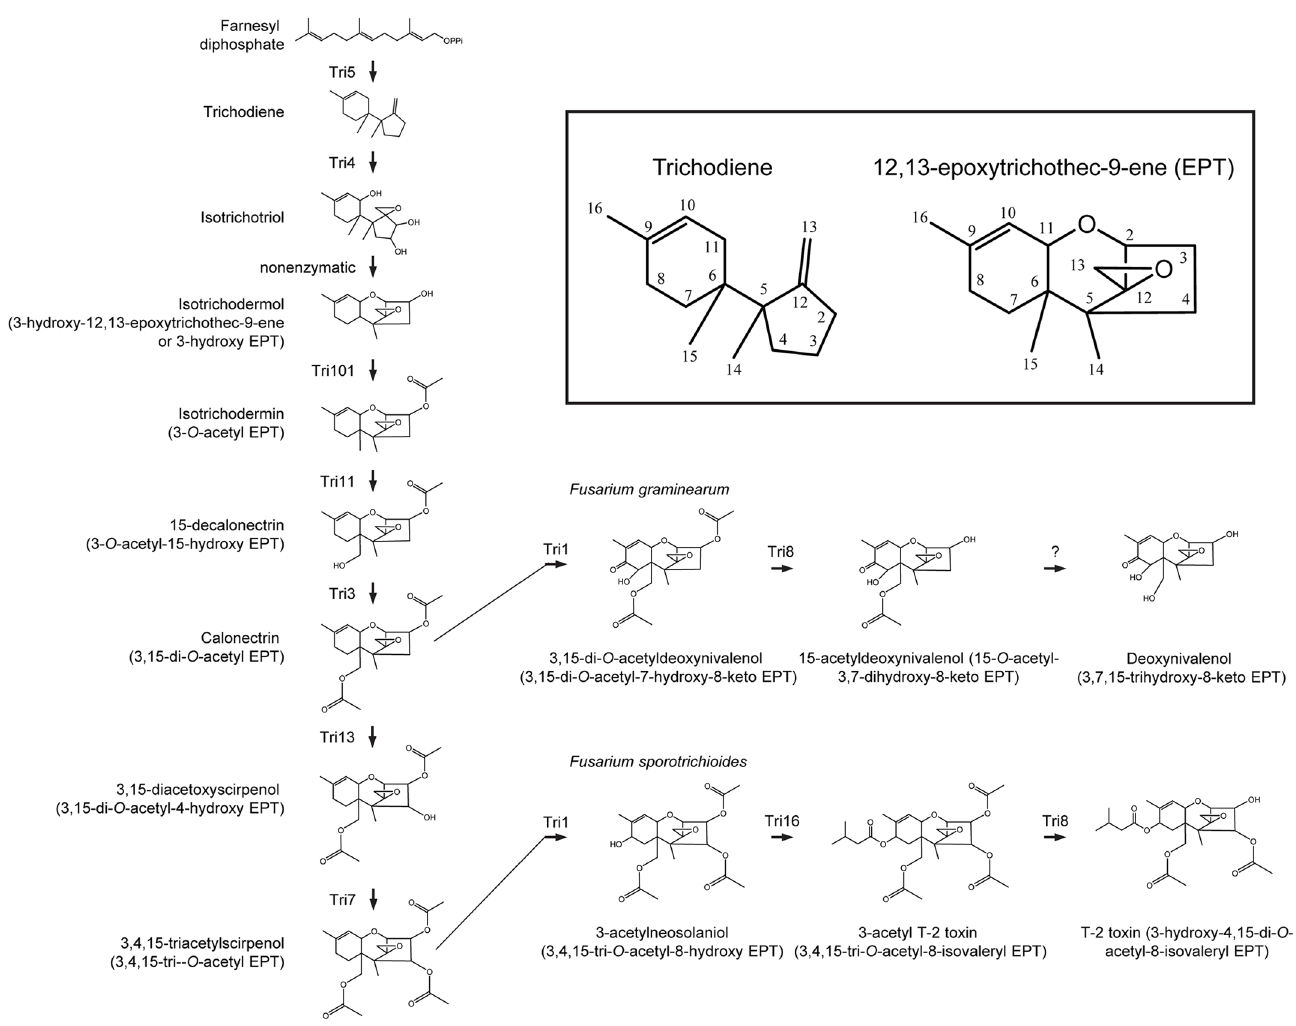
Fig 1. Biosynthetic pathways for the trichothecene analogs deoxynivalenol and T-2 toxin in Fusariumgraminearum and F . sporotrichioides ,respectively. The inset at the top right shows the structure and numbering systems for trichodiene and 12,13-epoxytrichothec-9-ene